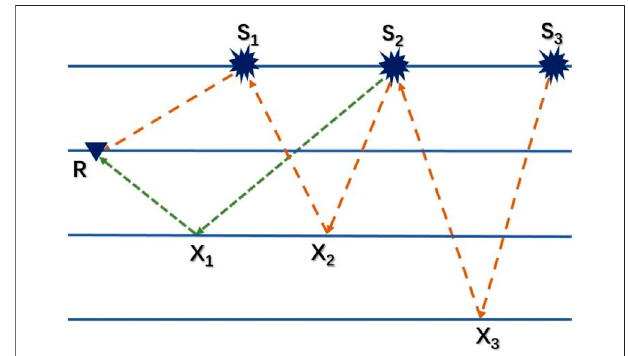
FIGURE 1 | Schematic diagram of DDM method for VSP data. In conventional migration of walkaway VSP data, the upgoing component recordedatRisbackwardpropagatedandcross-correlatedwiththeforward- propagated source wavelet excited at S 2 to image X 1 ; In migration of multiples. In migration of multiples, the receivers are considered to be virtual sources in the borehole and the sources located at the surface are taken as receivers for imaging multiples. The fi st-order multiples are backward extrapolatedfromS 2 andcross-correlatedwiththeforward-propagateddirect wavefrom S 1 toimage X 2 ; Similarly, thesecond-order multiples arebackward extrapolated and cross-correlated with the forward-propagated fi rst-order multiple to image X 3